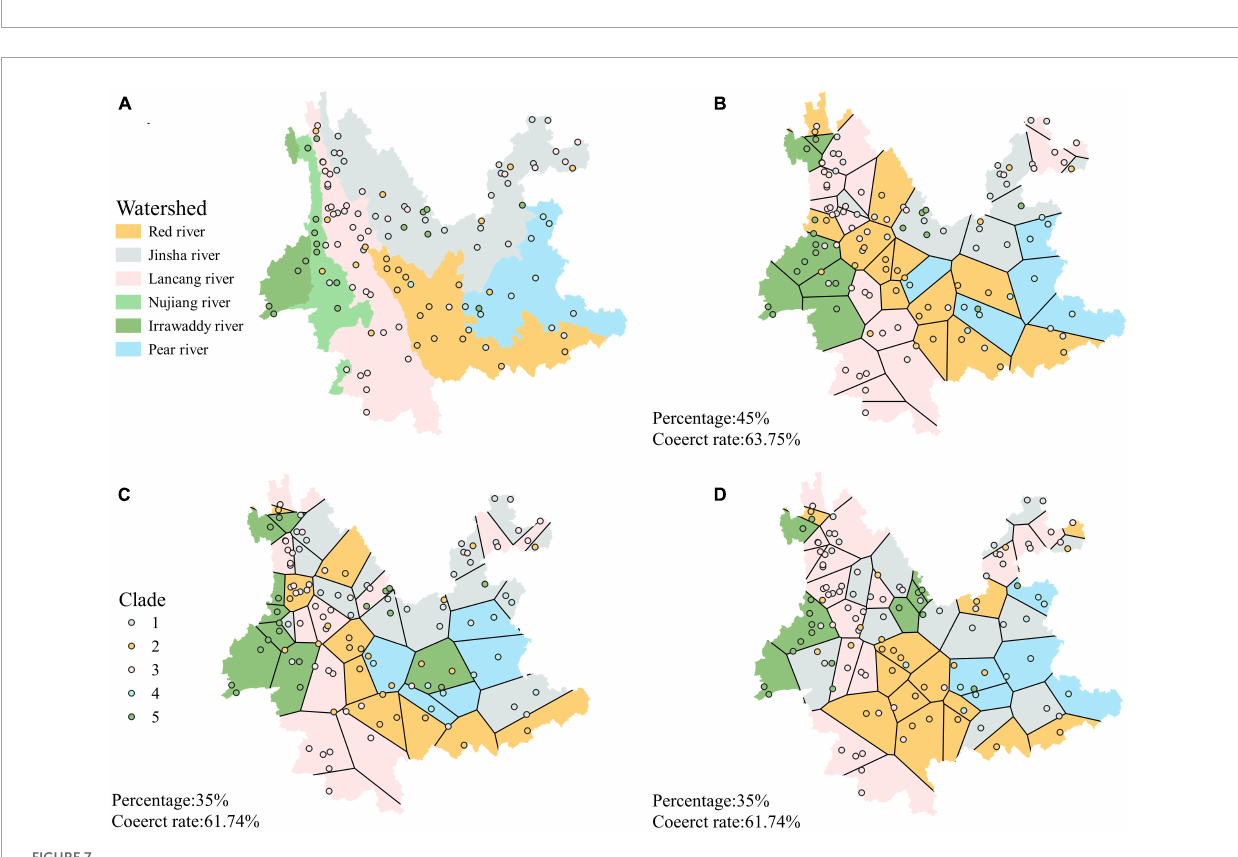
FIGURE7 (A) Clade distribution map of A. oligospora with watershed as a unit. (B–D) Three maps with the highest accuracy when Voronoi polygons are the